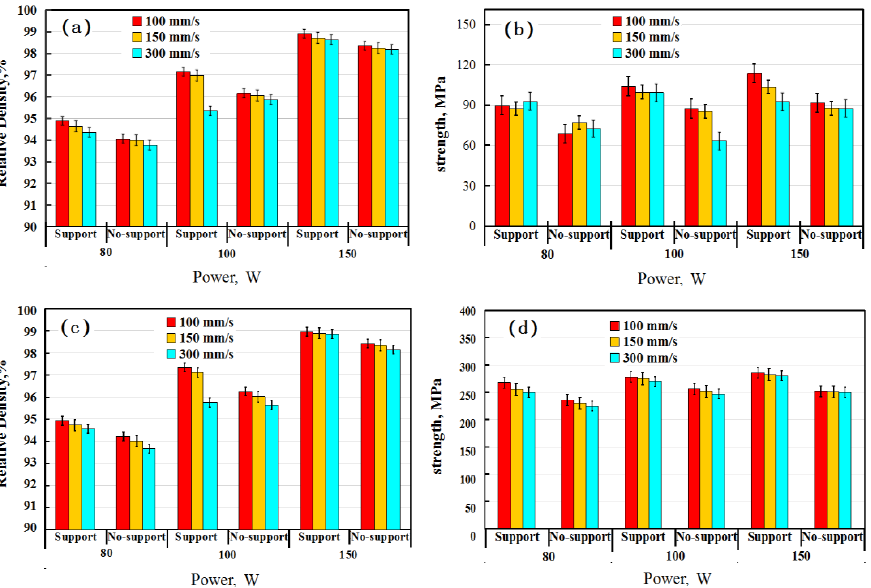
Figure 4. E ff ects of power and scanning speed on the relative density and strength of horizontal ( a , b ) and vertical ( c , d ) samples produced with and without support.